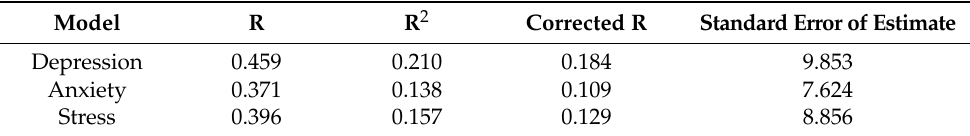
Table 5. Summary model for Depression, Anxiety and